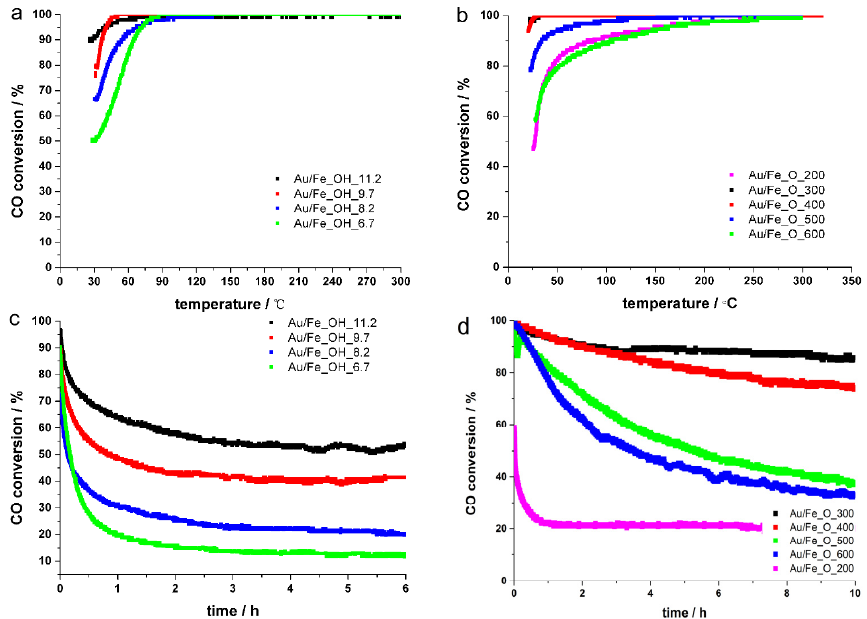
Figure 5. CO conversions of fresh Au/FeO x catalysts for the low ‐ temperature CO oxidation reaction: ( a ) Au/Fe_OH, transient; ( b ) Au/Fe_O, transient; ( c ) Au/Fe_OH, stability at 30 °C; and ( d ) Au/Fe_O, stability at 30 °C. Reaction conditions: 1% CO/20% O 2 /79% N 2 , 80,000 mL ∙ h − 1 ∙ g cat − 1 .